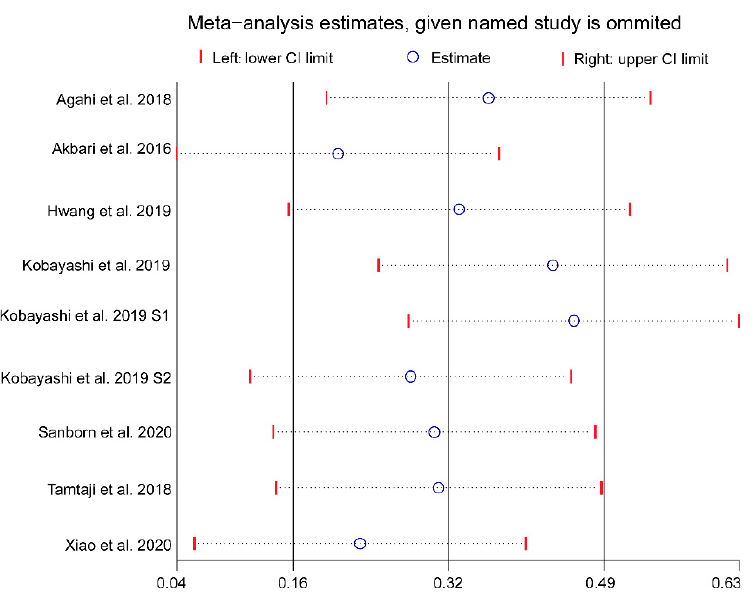
Figure 6. Results of sensitivity analysis using the leave-one-out method. Abbreviations: CI, confi- dence interval.